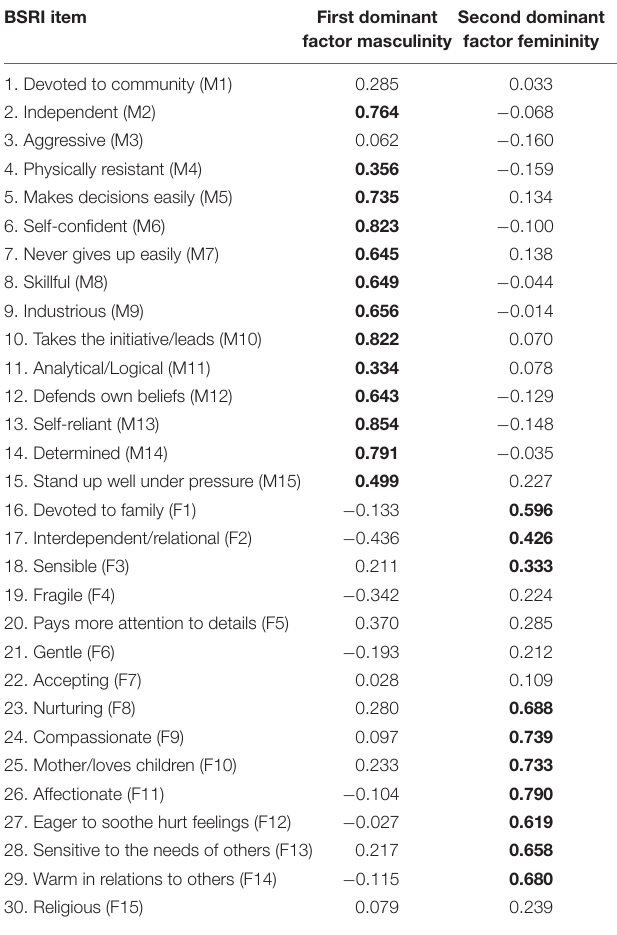
TABLE 1 | Factor loading for the first two dominant Bartlett